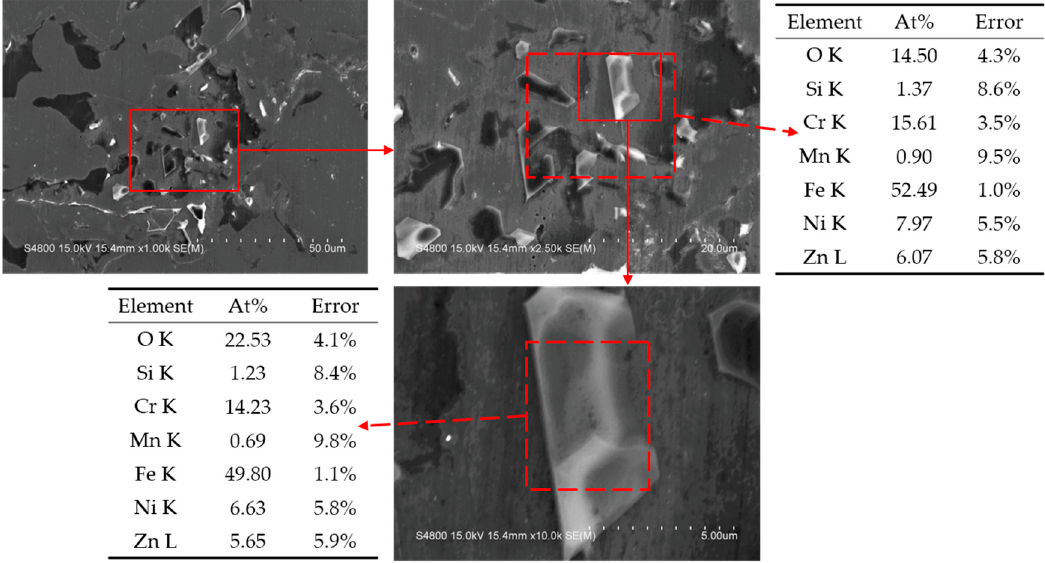
Figure 9. SEM images and the corresponding composition analysis of the passive film formed on 304L with the zinc treatment.